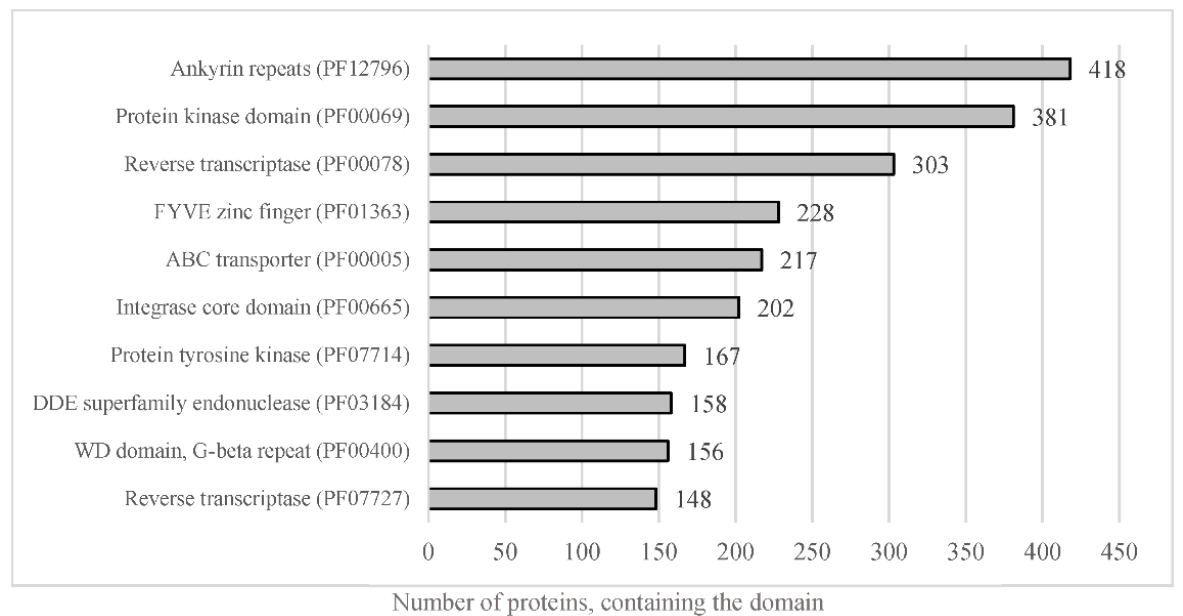
Figure 5. Representation of the most abundant PFAM predicted domain in the proteome of A. euteiches . When considering the number of proteins containing the most-present PFAM domains in total proteome, of the 23,027 total predicted proteins, around 56% harbor a PFAM domain.